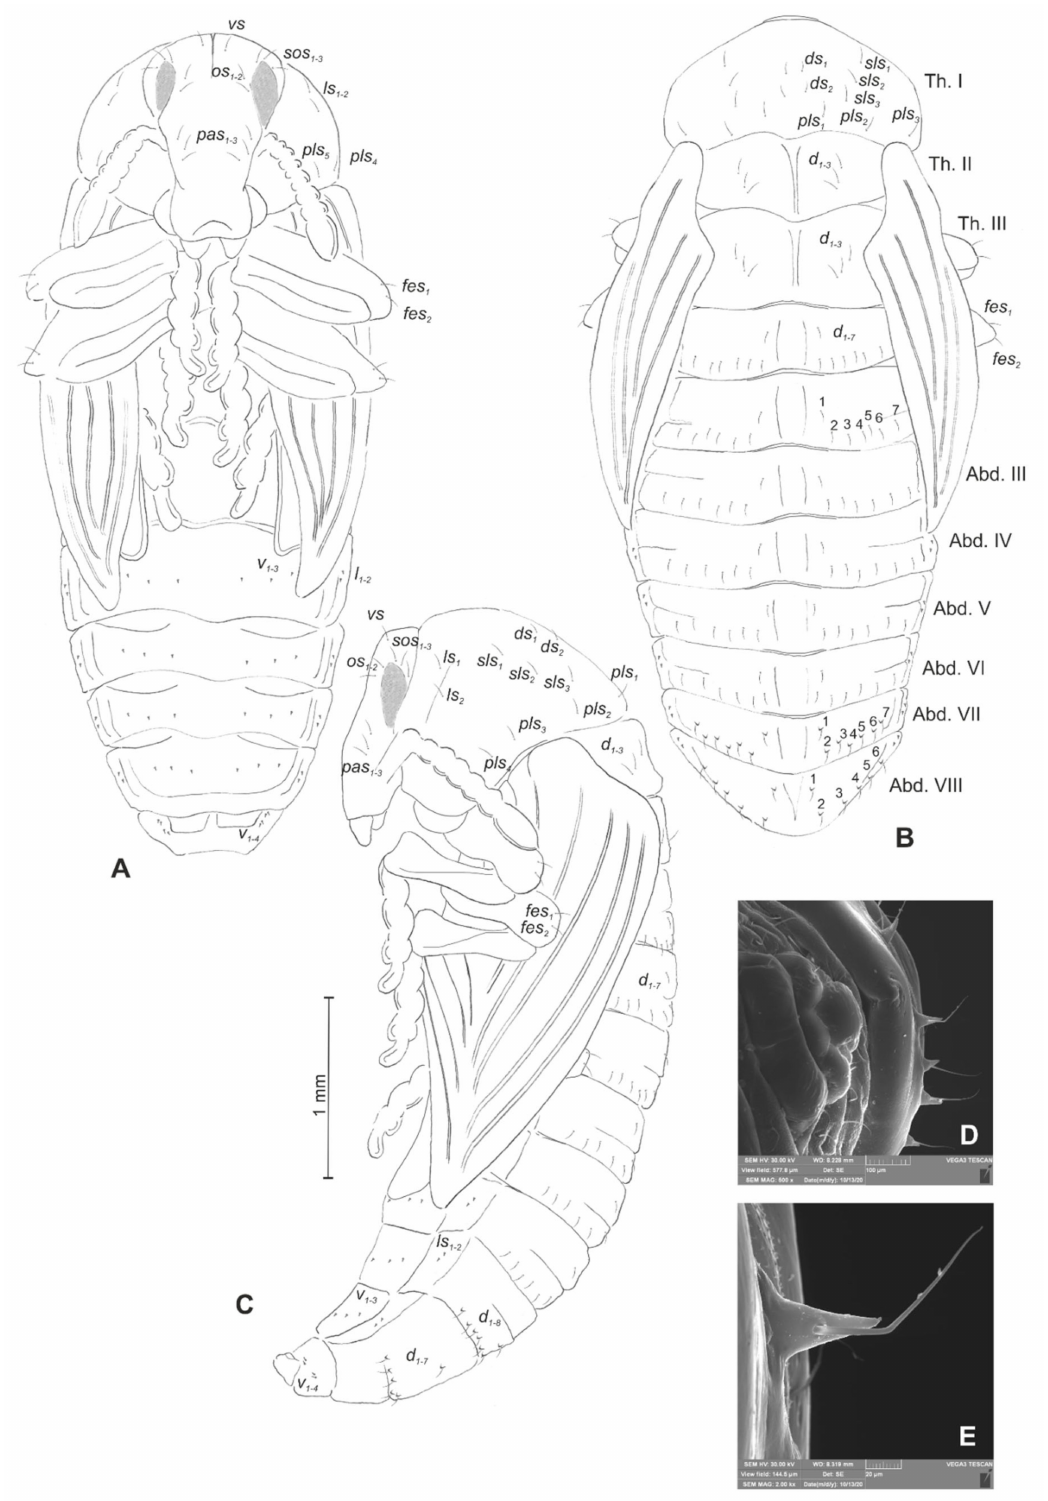
Figure 22. Rhinocyllus conicus pupa. ( A )—ventral view; ( B )—dorsal view; ( C )—lateral view; ( D , E )—Abd. VIII, dorsal view, magnification (Th. I–III—pro–, meso– and metathorax, Abd. I–IX—abdominal segments 1–9, ur—urogomphus, setae: as —apical, d —dorsal, ds —discal, fes —femoral, ls —lateral, os —orbital, pas —postantennal, pls —posterolateral, rs —rostral, sls